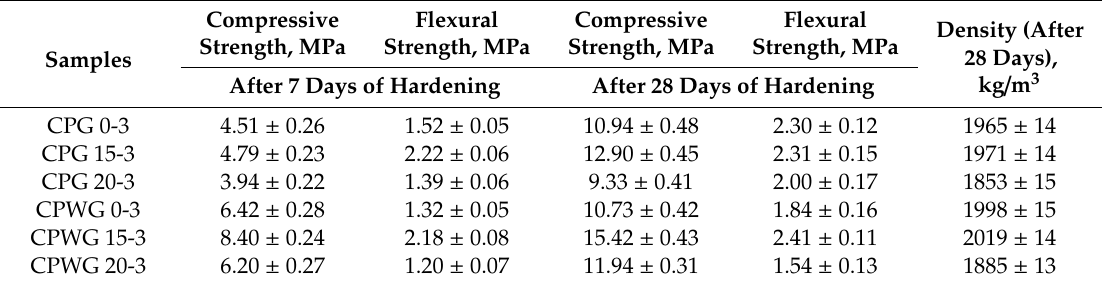
Table 4. Compressive strength, flexural strength and density of alkali activated fine-grained concretes samples.